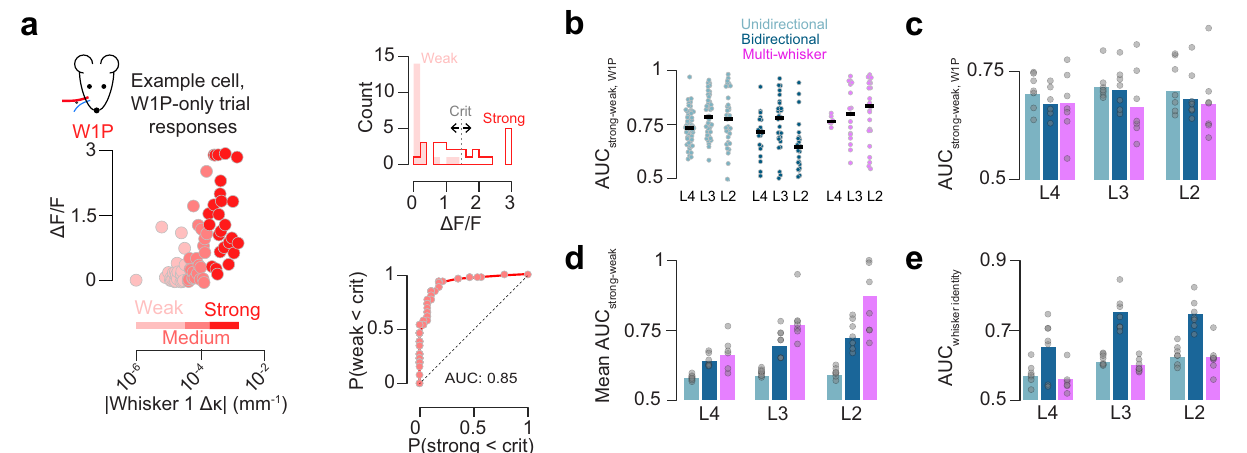
Fig. 5 | Decoding of touch features by neuron type and layer. a Example ROC analysisforsingleneurontouchforcedecoding(Methods).Left,per-trialpeak Δ F/F as a function of Δ κ . Shades of red indicate force bins each containing a third of trials. Top right, histogram of strong and weak Δ F/F responses, with example cri- terion point for generating ROC curve. Bottom right, example neuron ROC curve. b Decoding for all neurons from an example mouse of a given type and layer